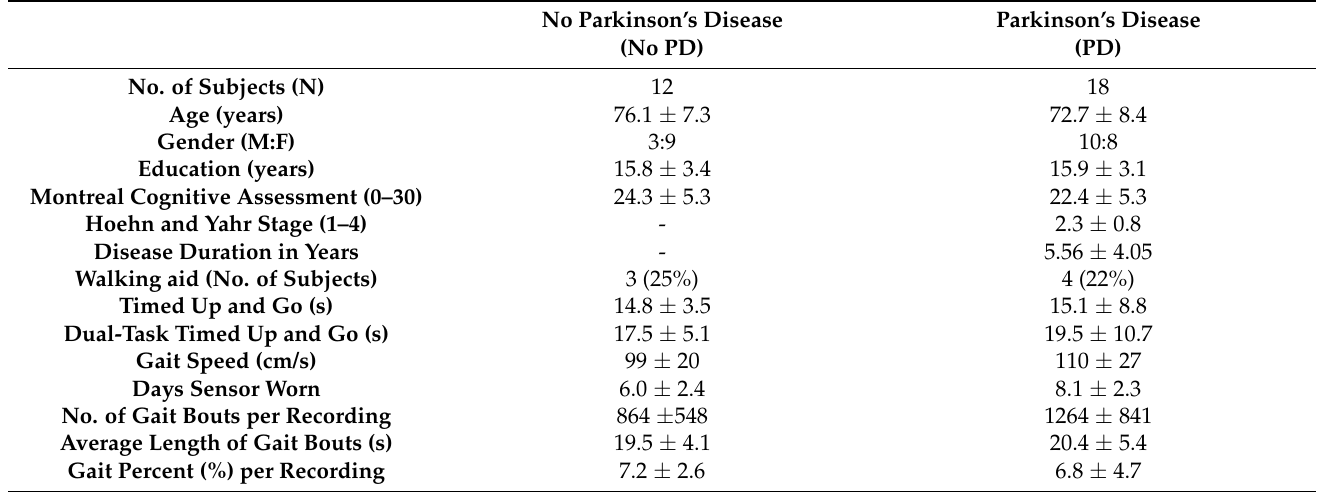
Table 1. Characteristics of the older adults analyzed in this study. No Parkinson’s Disease